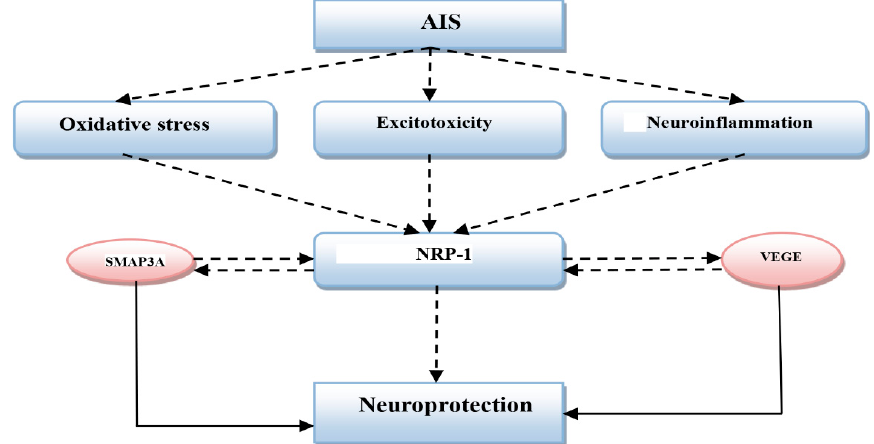
Figure 3. Role of neuropilin-1 receptors (NRP-1) in acute ischemic stroke (AIS): AIS triggers the development of oxidative stress, excitotoxicity, and neuroinflammation that activate the expression of NRP-1. In turn, NRP-1 activates expressions of vascular endothelial growth factor (VEGF) and semaphoring P3A (SMAP3A), which stimulate NRP-1 receptors leading to neuroprotection. Human studies have indicated that post-stroke cellular events are involved in neu- ronal regeneration through the NRP-1-dependent pathway [43]. Mehta et al. revealed that endothelial NRP-1/VEGF signaling is activated by disintegrin and metalloproteinases (ADAMs). So, ADAM inhibitors may reduce NRP-1 activity and NRP-1-induced VEGF activation [44]. Clinical studies have shown that mild AIS induces the release of VEGF, which promotes angiogenesis and protects ischemic neurons from damage, encouraging neuronal plasticity through anti-inflammatory effects. However, severe AIS prompts BBB injury and may exacerbate brain injury [45]. Slevin et al. disclosed that VEGF serum level is correlated with the severity of AIS [46]. These findings suggest that the immunological reaction to AIS is mediated by VEGF, which could be of great value in assessing the status and recovery of patients with AIS. Therefore, VEGF through an NRP-1 or NRP-1 independent pathway may be in- volved in the pathogenesis of AIS. Thus, the modulation of the VEGF/NRP-1 axis could be of great value in the management of AIS. 3. Acute Ischemic Stroke in Viral Infections AIS is not uncommon with various types of viral infections, since acute and chronic viral infections can provoke AIS through alterations of the underlying atherosclerotic pro- cess and immune-hematological reactions [47]. Indeed, AIS has an undesirable impact on the immune response against viral infections due to AIS-induced immunodepression causing profound post-stroke complications. So, post-AIS infection is regarded as an in- dependent predictor of poor clinical outcomes [47]. Manousakis et al. divulged that AIS disrupts the protective mechanisms against acute viral infections via the induction of im- munosuppression and release of anti-inflammatory cytokines. Therefore, the risk of viral infections following AIS is augmented via a paramount immunological circuit [48]. During respiratory viral infections (RTIs), the platelet activation and reactivity are augmented with an increase in the pro-aggregatory state, which increases the risk of AIS [49]. Different case-control studies have confirmed the close relationship between RTIs and AIS [50]. It has been shown that the influenza viral infection is associated with an